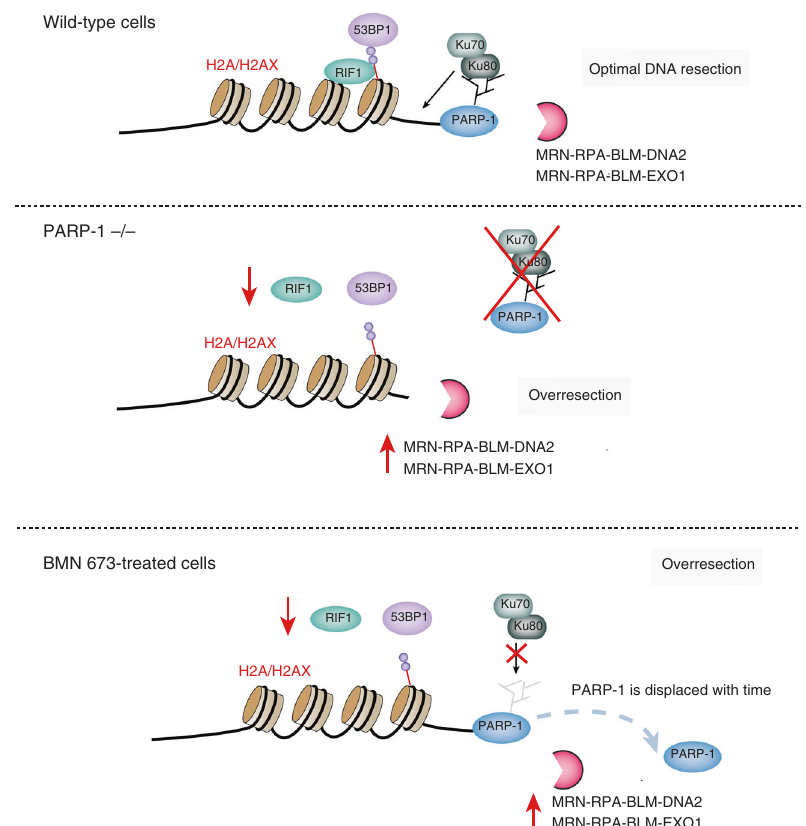
Fig. 8 Model. Following DNA damage, poly(ADP-ribose) polymerase-1 inhibition leads to a decrease of Ku80-end protection, RIF1 and 53BP1 foci formation, and increased DNA resection. Details are given in the